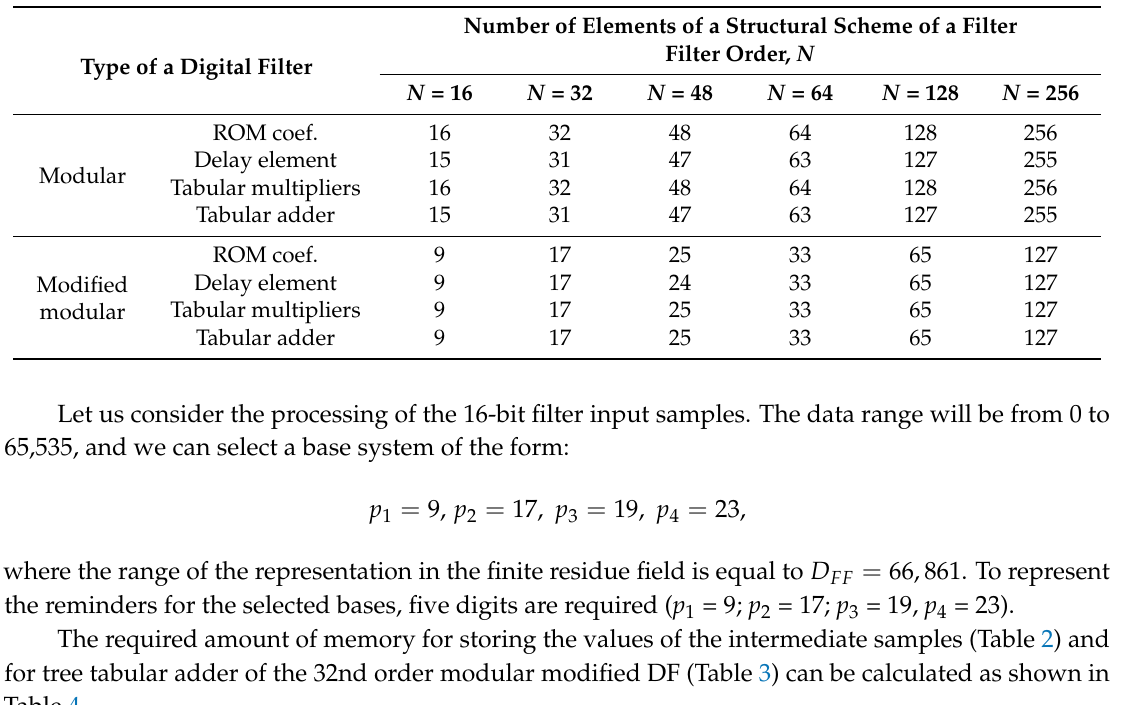
Table 3. Estimation of the elements number in the structures of modular and modified modular DF.